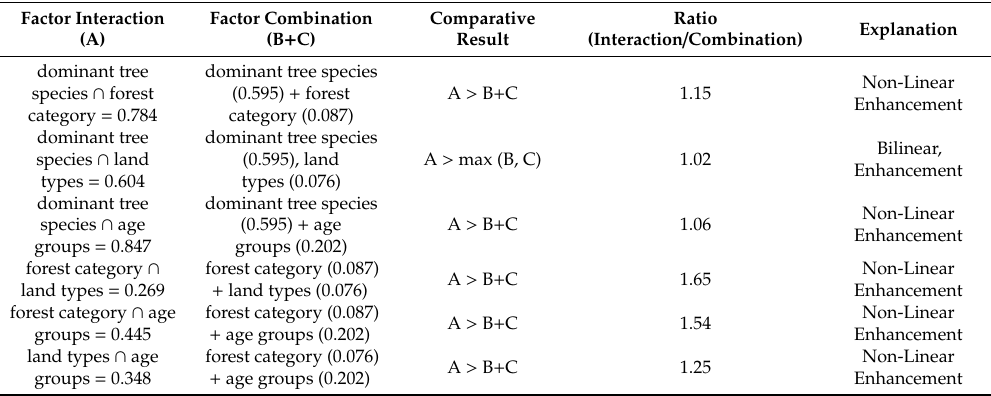
Table 6. Comparison of interactions between factors pairs.